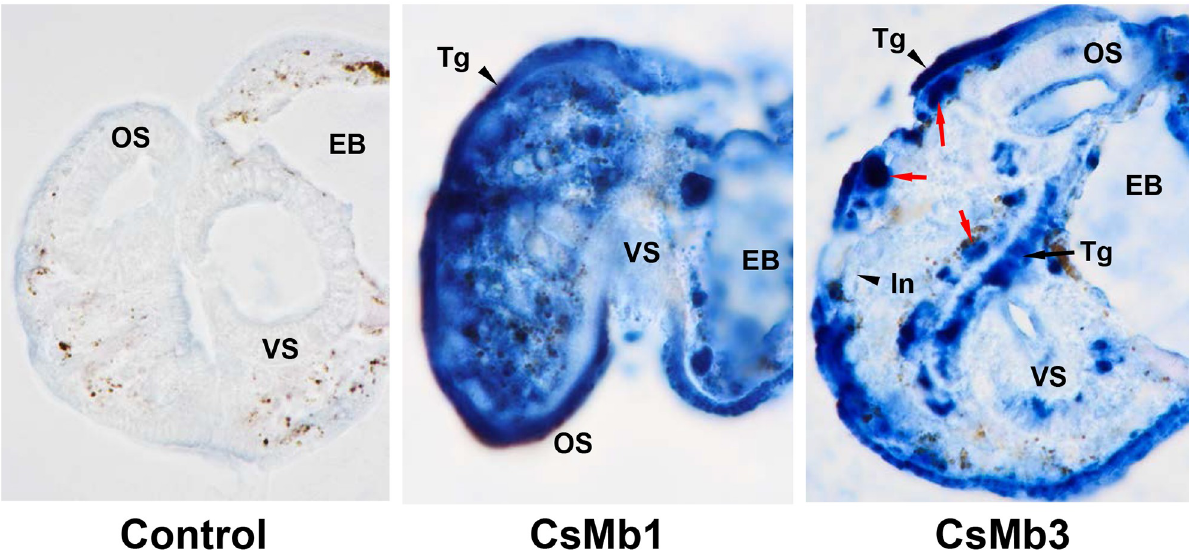
Fig 7. Detection of CsMb1 and CsMb3 in the metacercarial stage of Clonorchis sinensis . The whole-body sections of C . sinensis metacercariae embedded in paraffin were reacted with mouse antibodies specific to the recombinant forms of C . sinensis CsMb1 and CsMb3. Pooled serum from pre- immune mice (n = 3) was used in the control reaction. The positive reactions were developed into a blue color using a blue chromogen substrate for horseradish peroxidase-conjugated to a second antibody. The red arrows mark a follicle-like structure exhibiting a strong positive signal against the anti-CsMb3 antibody in the subtegumental region. EB, excretory bladder; In, intestine; OS, oral sucker; Tg, tegument; VS, ventral sucker. Original magnifications, x 1,000.